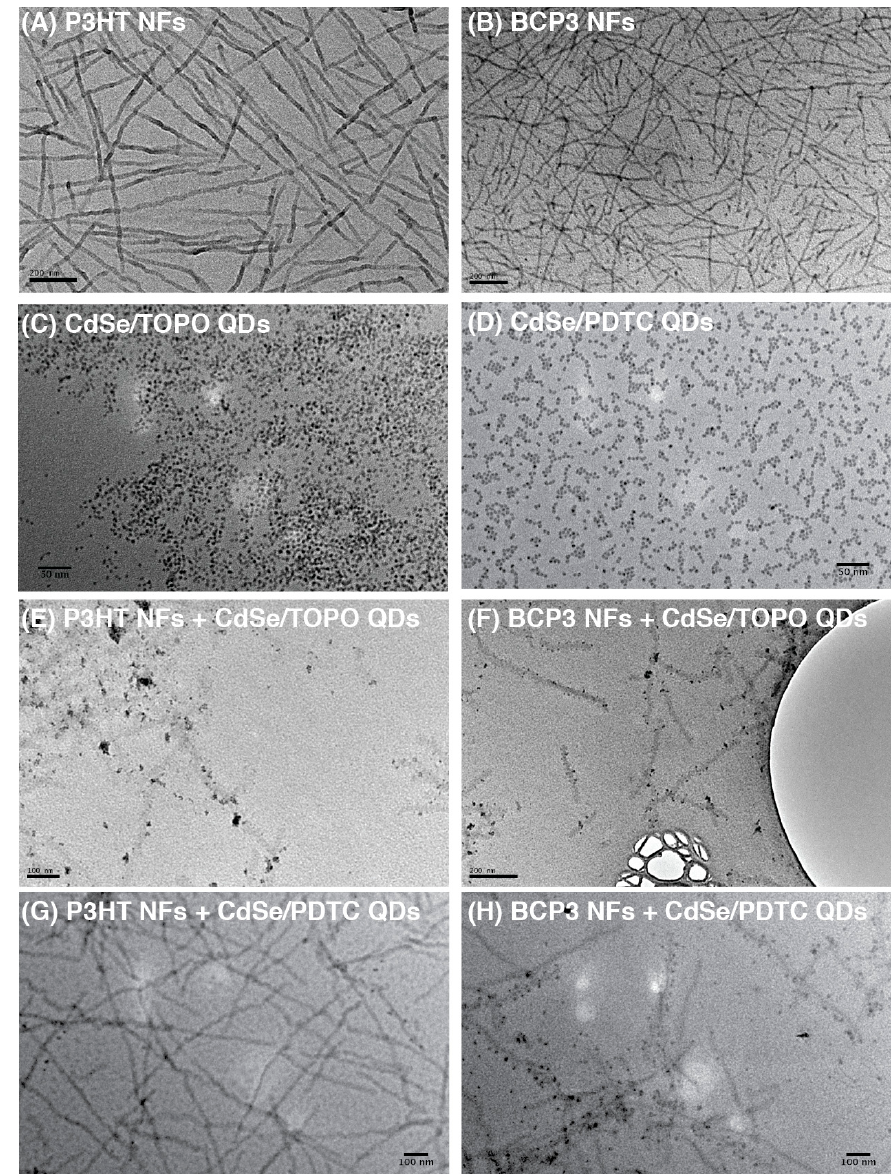
Figure 4. Transmission electron microscopy (TEM) images of: ( A ) P3HT nanofibers (NF)s; ( B ) BCP3 NFs; ( C ) CdSe quantum dots (QDs) with TOPO ligands; ( D ) CdSe QDs with PTDC ligands; ( E ) P3HT NFs with CdSe QDs having TOPO ligands (1/1, w / w ); ( F ) BCP3 NFs with CdSe QDs having TOPO ligands (1/1, w / w ); ( G ) P3HT NFs with CdSe QDs having PTDC ligands (1/1, w / w ); and ( H ) BCP3 NFs with CdSe QDs having PTDC ligands (1/1, w / w ).